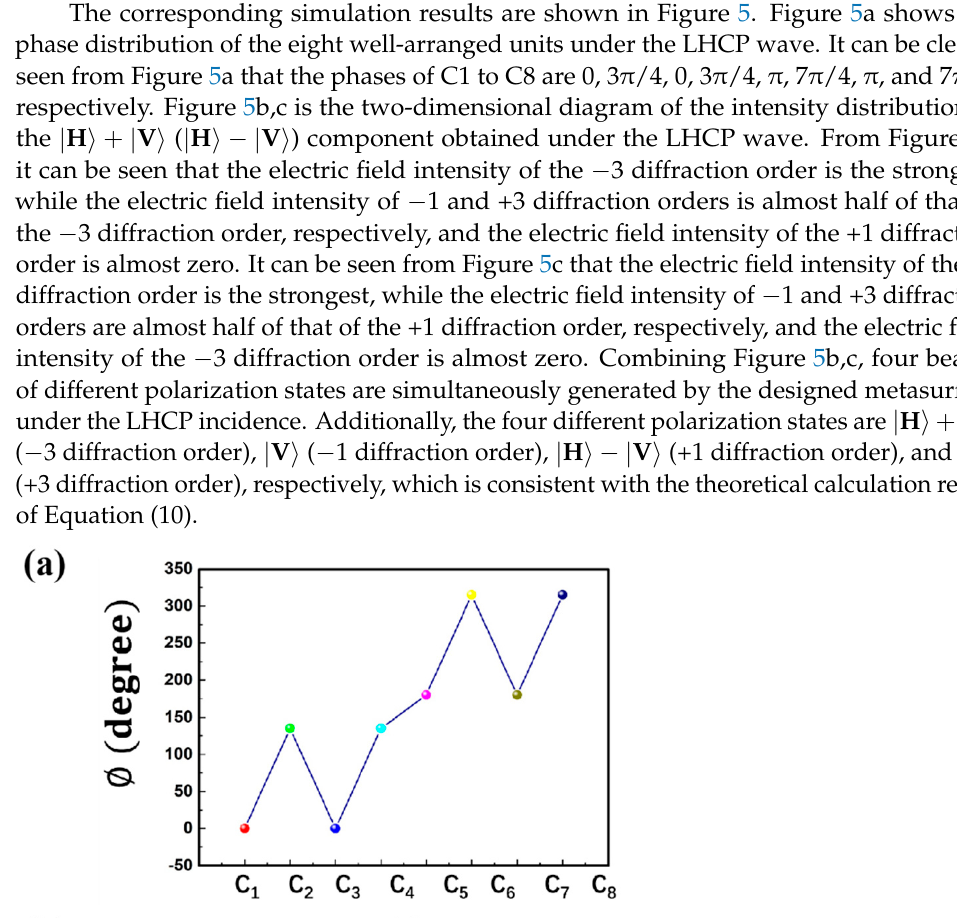
Figure 5. Under LHCP incidence, ( a ) the phase distribution of 8 units, ( b ) the intensity profile of | H (cid:105) + | V (cid:105) component, and ( c ) the intensity profile of | H (cid:105) − | V (cid:105) component are + H V component, and ( c ) the intensity profile of